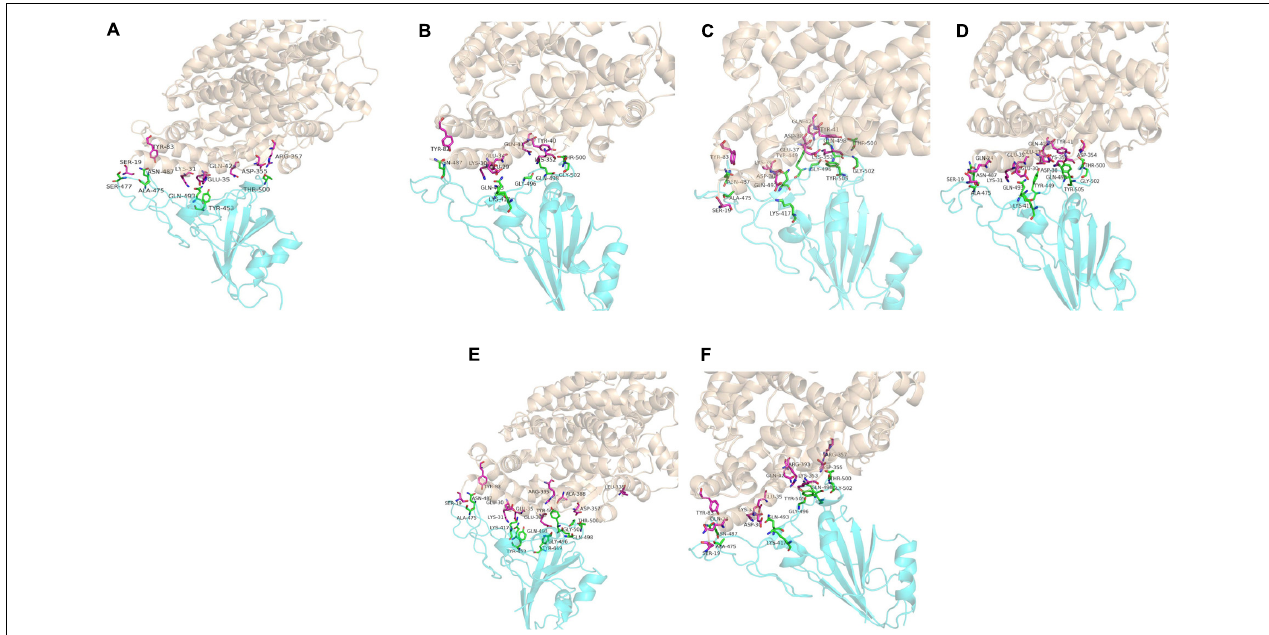
FIGURE 2 | Overall structure of SARS-CoV-2 RBD bound with ACE2. (A–F) Are respectively human, dogs, chimpanzees, cattles, cats, Rhesus monkey. ACE2 is colored light coffee. SARS-CoV-2 RBD core is colored cyan. Amino acid interaction sites are also shown. TABLE 4 | Eight drugs selected from the ACE2(cats)-SARS-CoV-2-RBD model. Drug